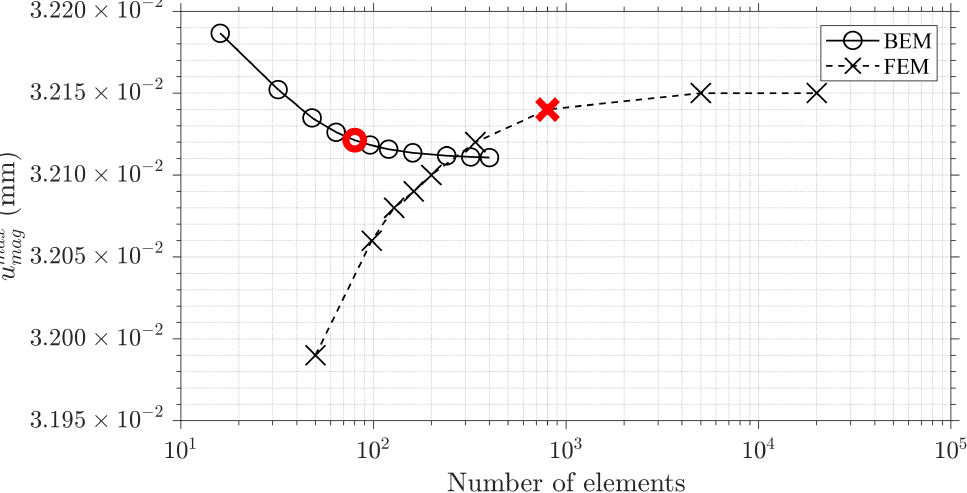
Figure 8. Mesh convergence with the Boundary Element Method (BEM) and the Finite Element Method (FEM). The BEM and FEM meshes considered to have reached convergence are shown as red markers.